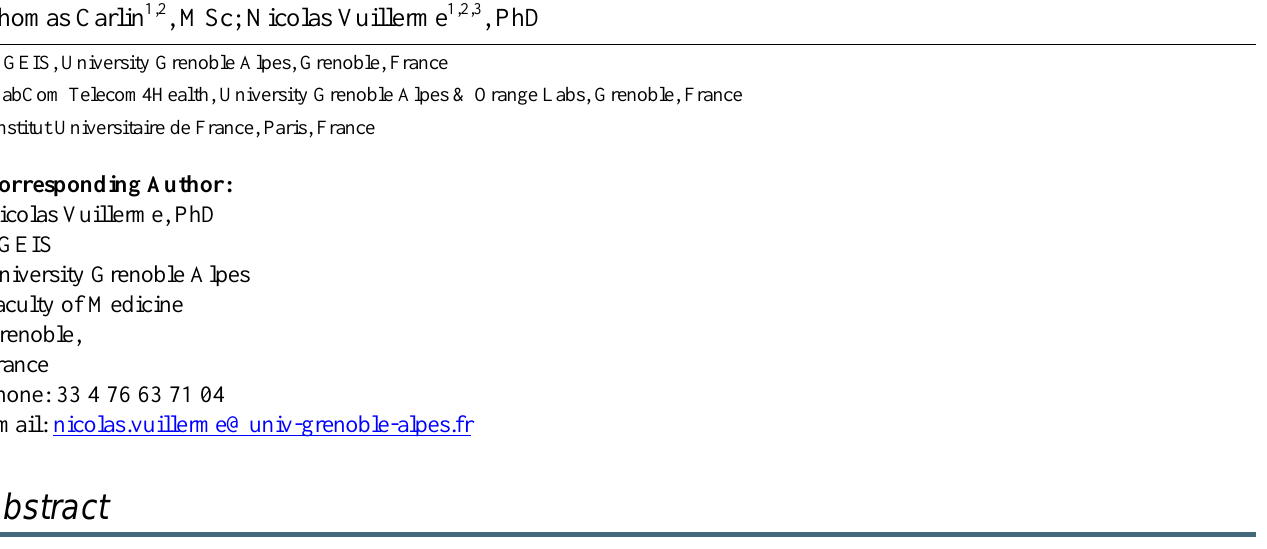
activity monitor; pedometer; measurement; validity; reliability; walking; step count;